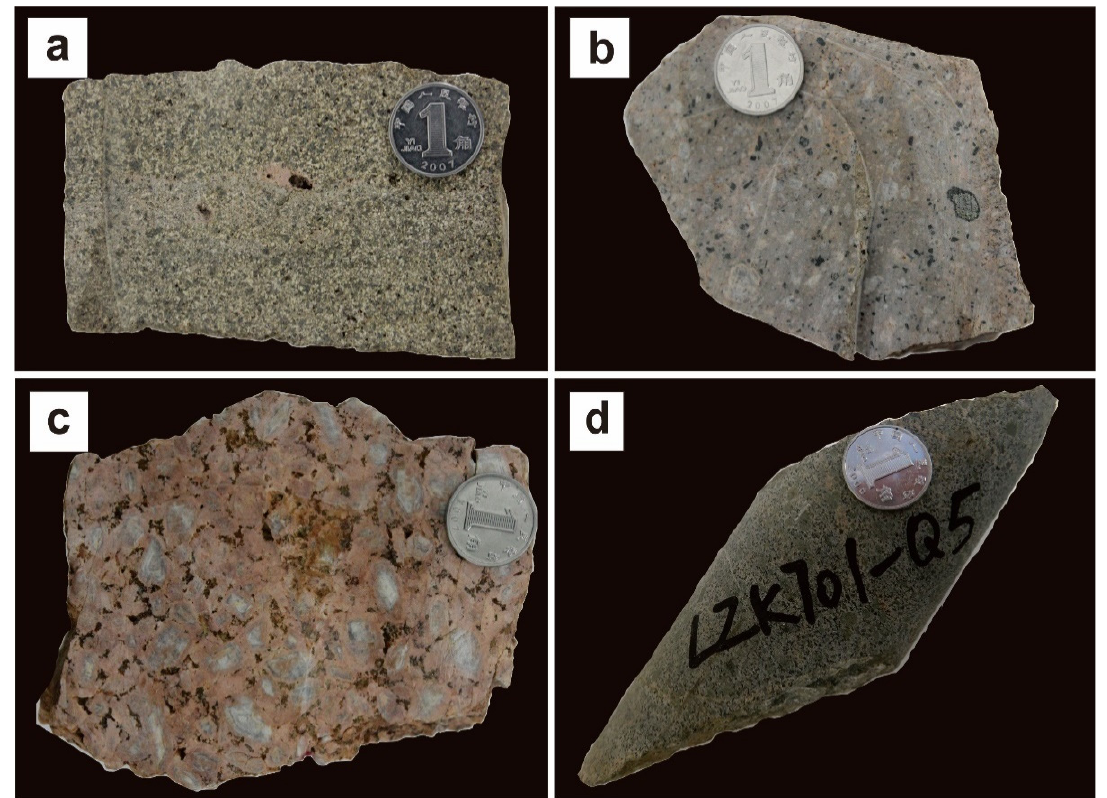
Figure 2. Photographs of alkaline complex from the Longbaoshan area. ( a ) Hornblende diorite. ( b ) Hornblende syenite porphyry. ( c ) Biotite monzonite porphyry. ( d ) Aegirine diorite porphyrite.